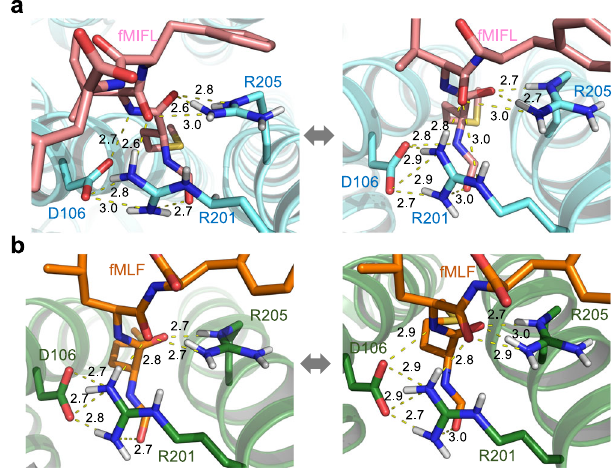
Fig. 3 | MD simulation of the Cryo-EM models. Two representative hydrogen- bonds networks characterized by either minimizing the average donor-acceptor (D – A)distanceormaximizingthenumberofconcurrenthydrogen-bondsfromthe conformationensembleofthewhole3- µ strajectoriesofFPR1-Gi-scFv16boundwith fMIFL ( a ) and fMLF ( b ). Both representatives show that the formyl group is recognized by the D106 3.33 -R201 5.38 -R205 5.42 motif, in particular the salt bridge between D106 3.33 and R201 5.38 stabilized the side-chain orientation of R201 5.38 . The residues D106 3.33 -R201 5.38 directly recognizes the formyl-O of fMLF (or fMIFL), as both the short-range H-bond (left) and the long-range electrostatic attraction (right) could be offered by the positively charged guanidino group of R201 5.38 during the thermodynamics fl uctuation. The yellow dashed lines indicate distance shorter than 3Å. Source data are provided as a Source data fi